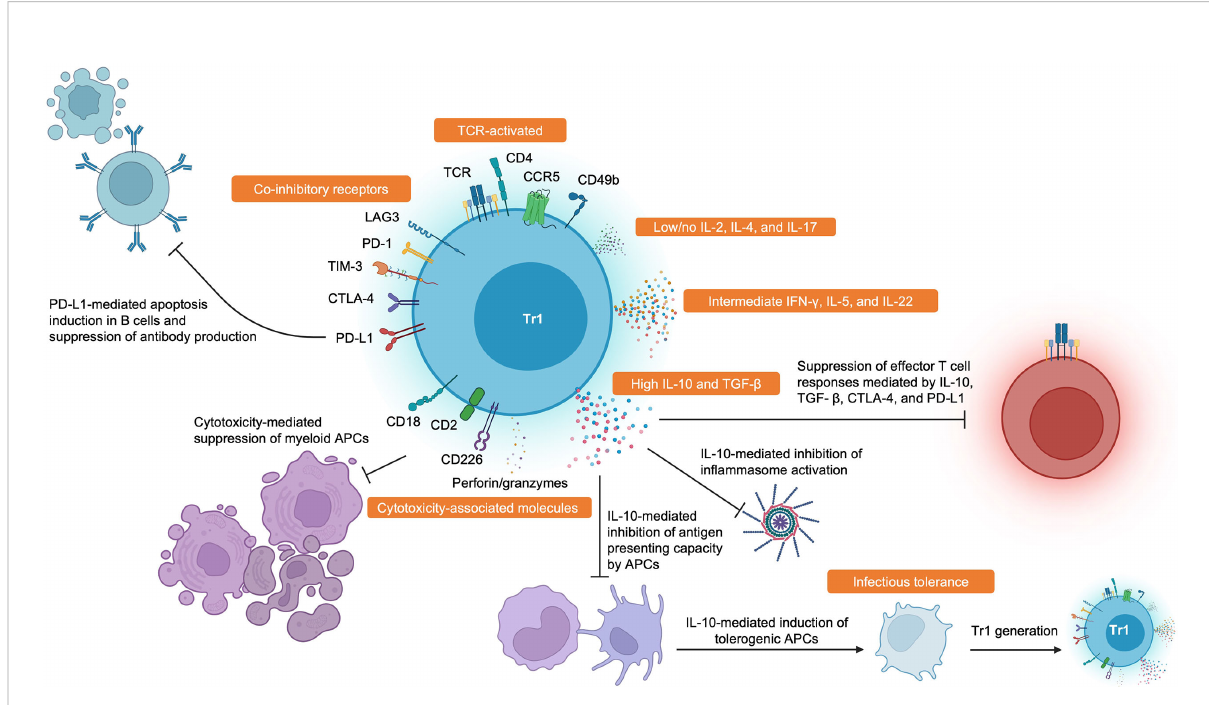
FIGURE 1 Hallmark Features and Functions of Tr1 Cells. Tr1 cells display high surface expression of CD49b, CCR5, CD2, CD18, CD226, and many co- inhibitory receptors such as LAG-3, PD-1, TIM-3, CTLA-4, and PD-L1. Tr1 cells characteristically secrete large amounts of IL-10 and TGF- b , intermediate amounts of IFN- g and IL-5, and little to no IL-2 and IL-4. Tr1 cells have also been recently described to produce IL-22. Tr1 cells can suppress pathogenic immune responses through various mechanisms such as impairing antibody production by B cells, inducing PD-L1- mediated apoptosis in B cells, direct cytolysis of myeloid antigen presenting cells, reducing antigen presenting capacities by antigen presenting cells, induction of infectious tolerance, and direct inhibition of effector T cell responses through cytokine- and contact-dependent mechanisms. Created with